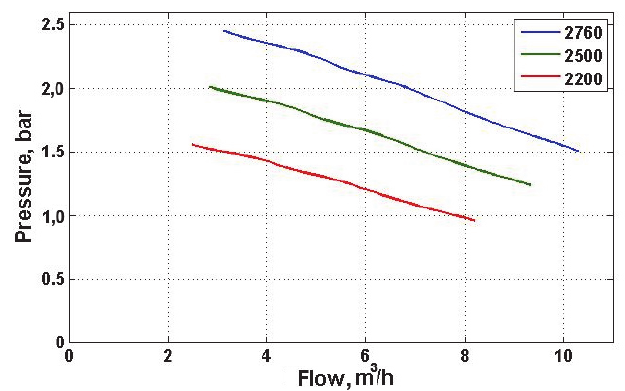
Fig. 7. Performance curves for different rotational speeds for EbaraCDX120/12.